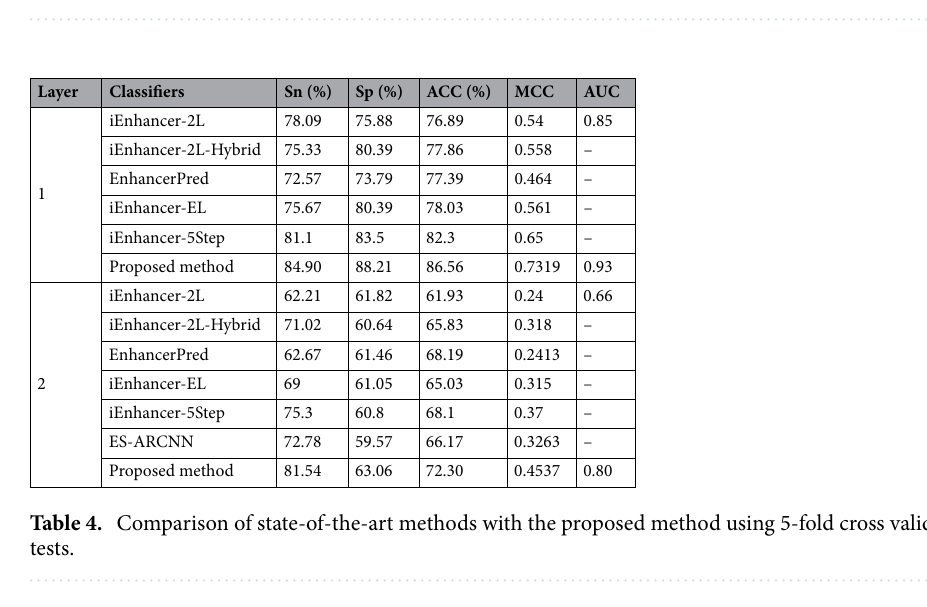
Table 3. Description of equations used Eqs. (26).